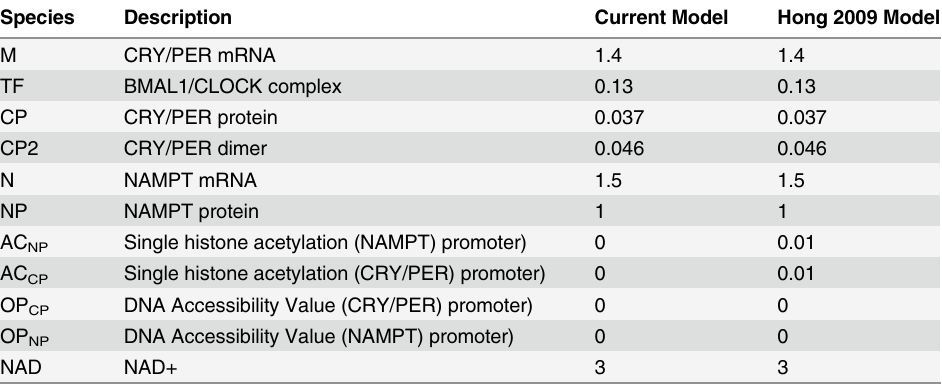
Table 3. Initial values for the current and the Hong 2009